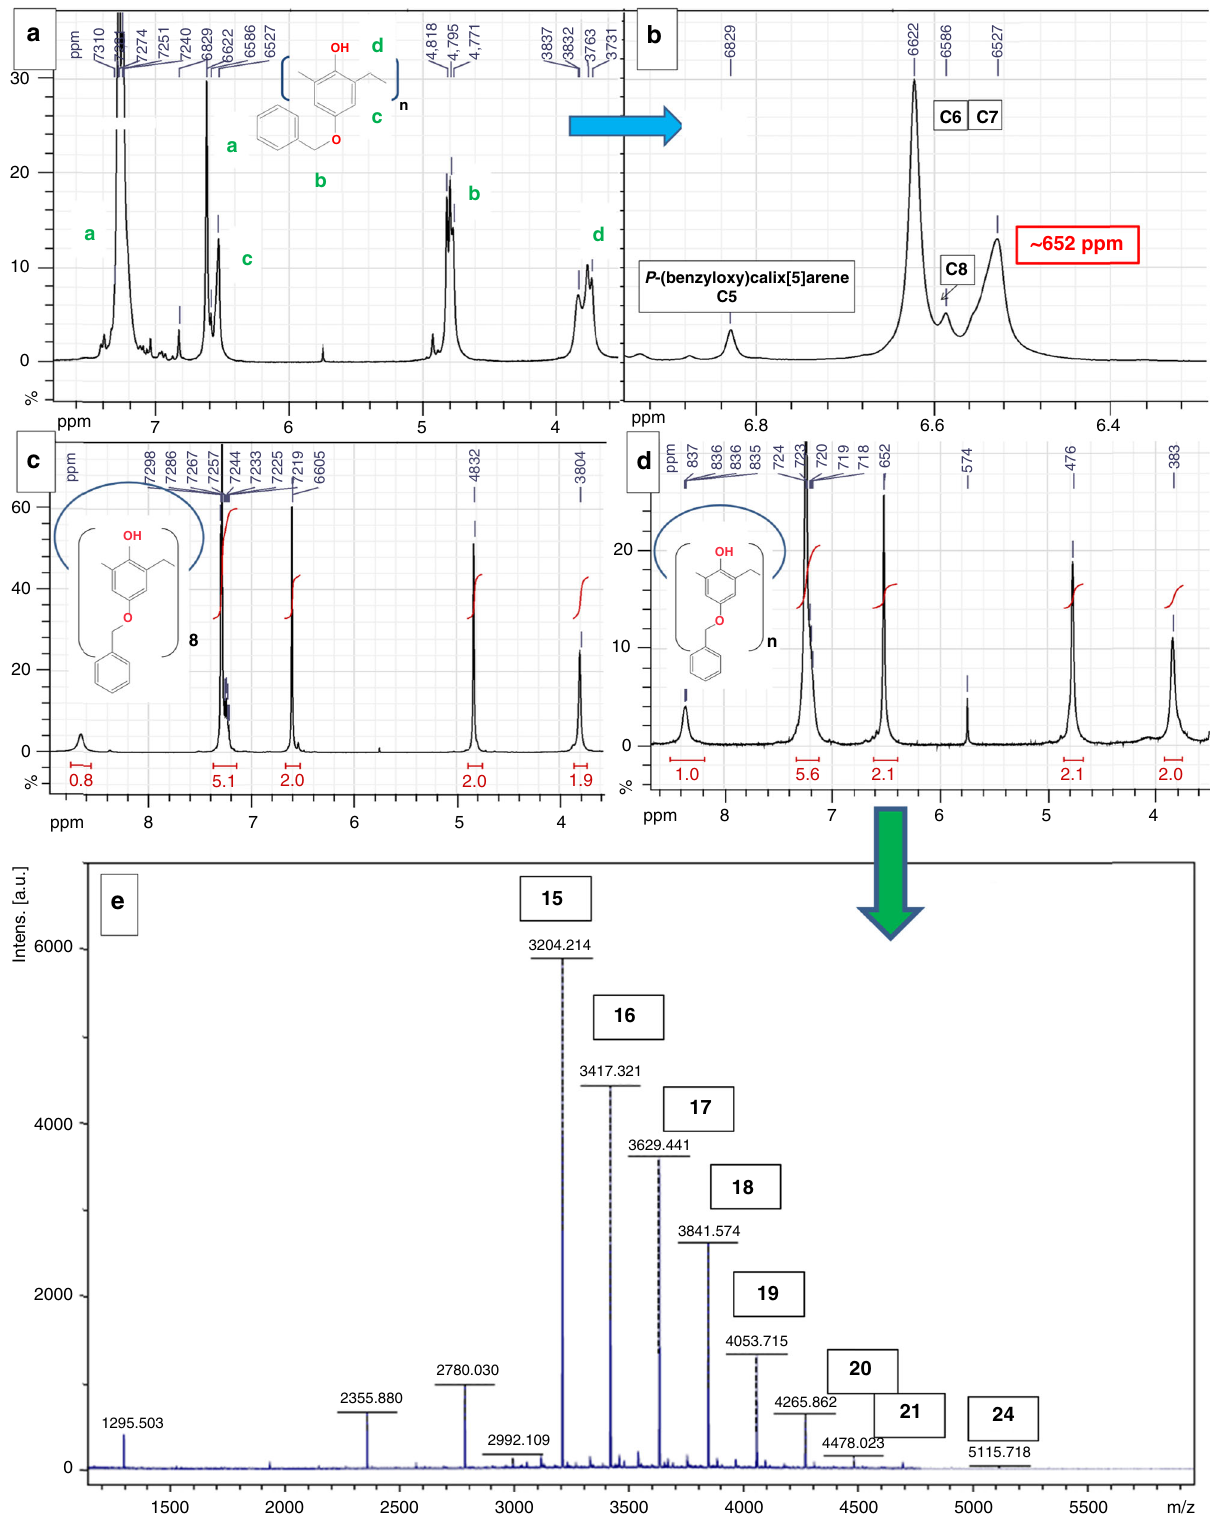
Fig. 2 First evidences of giant calixarenes. a 1 H NMR analysis (DMSO-d6) of the crude mixture of calixarenes obtained from a RbOH-catalyzed reaction (0.3 equivalent vs. phenol); b Zoom over the hydroquinone protons area; c 1 H NMR spectrum of the fi rst precipitate obtained by hot fi ltration of